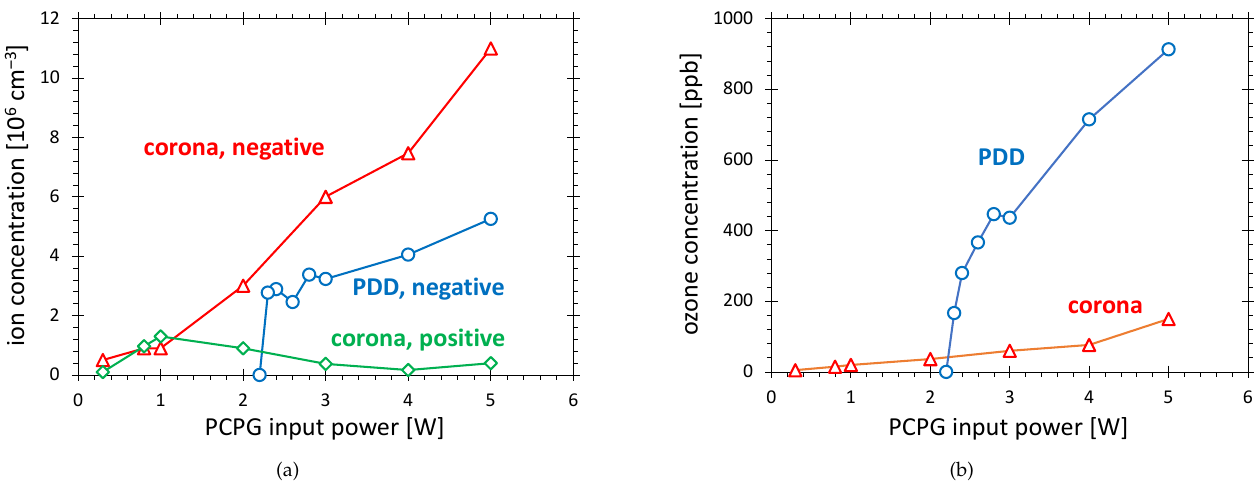
Figure 4. Comparison of the ion and ozone concentration for PDD (configuration 2) and corona (configuration 3) as a function of PCPG power. ( a ) Ion concentration and ( b ) ozone